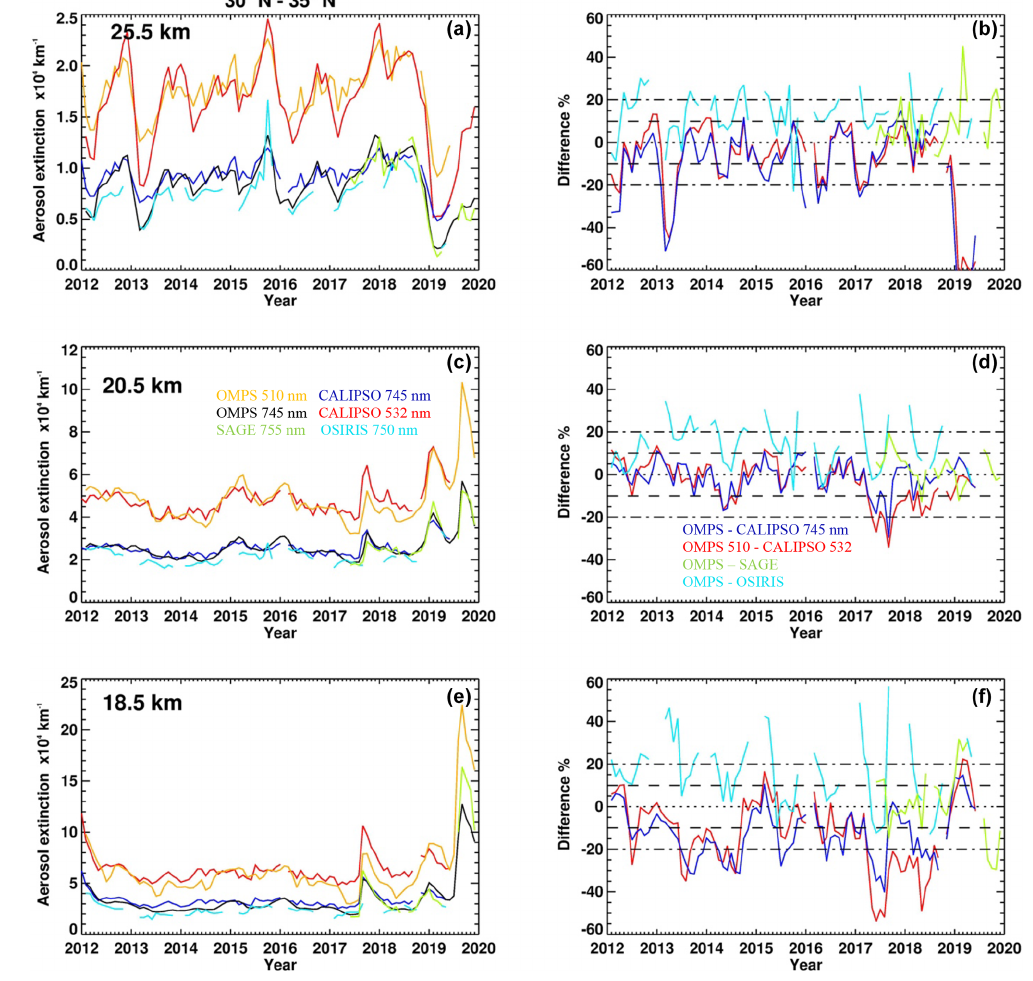
Figure 14. Panels (a) , (c) and (e) are CALIPSO 532 (red) and 745 (blue), OMPS LP 510 (orange) and 745 (black), OSIRIS 750 (light blue), and SAGE III/ISS 755nm (green) aerosol extinction monthly zonal mean, latitude zone 30 and 35 ◦ N for altitudes 25.5 (top), 20.5 (middle) and 18.5km (bottom), from 2012 to 2019. Panels (b) , (d) and (e) are the percent difference between OMPS LP and other